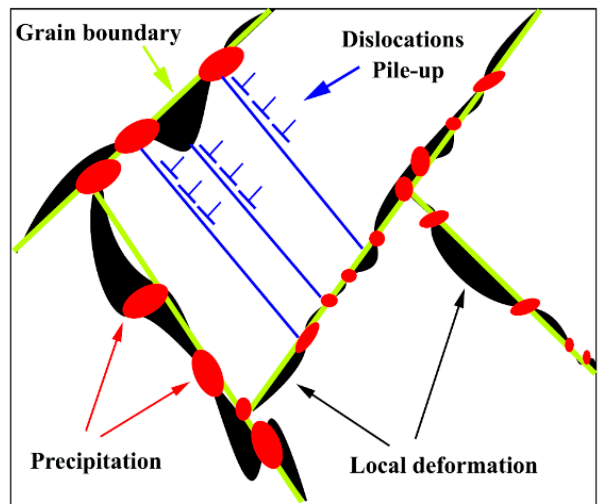
Figure 6. Schematic of precipitation strengthening of the grain boundary.